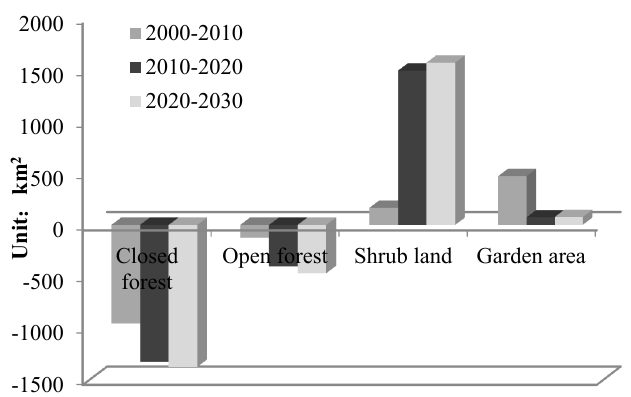
Figure 6. Forestland change under AIM climate scenario.